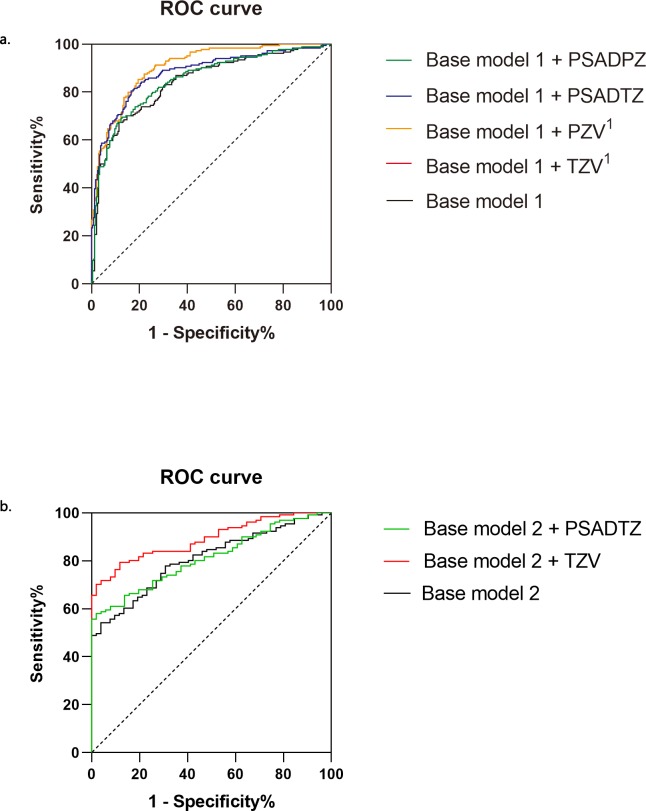
Receiver-operating characteristic curves depicting the accuracy of predictors of PCa (a.) and HR-PCa (b.) at the initial biopsy. Base model 1, PSA + PV + PSAD + MR; Base model 2, PV + PSAD + MR. 1Base model 1 + TZV and Base model 1 + PZV had the same AUC.